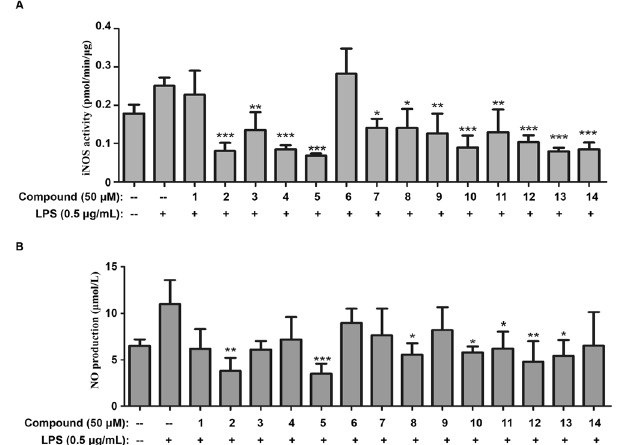
Figure 6. Effects of isolated compounds on iNOS enzyme activities and NO production in LPS-stimulated BV2 microglia cells. ( A ) Assays of iNOS enzyme activities. BV2 cells were pre-treated with all compounds (50 μ M) for 1 h, and stimulated with 0.5 μ g/mL LPS for 24 h. The activities of iNOS enzyme were determined by using nitric oxide synthase activity assay kit (Abcam). The results were presented as mean ± SD (n = 3) and analyzed by one-way ANOVA with Dunnett’s test. * p < 0.05; ** p < 0.01; *** p < 0.001. (Drug treatment plus LPS vs LPS). ( B ) Determination of NO levels in culture medium. After the drug treatment as previously described, the culture medium was collected for measurement of NO production by using Griess reagent kit for nitrite determination. Data were expressed as mean ± SD (n = 3) and analyzed by one-way ANOVA with